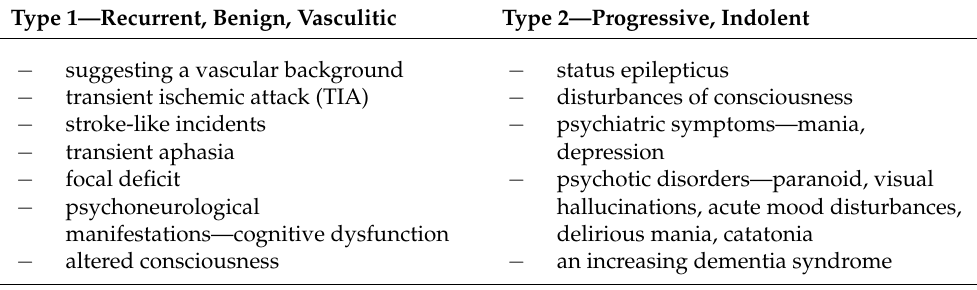
Clinical types of Hashimoto encephalopathy—according to [7,9,58,60]—author’s own